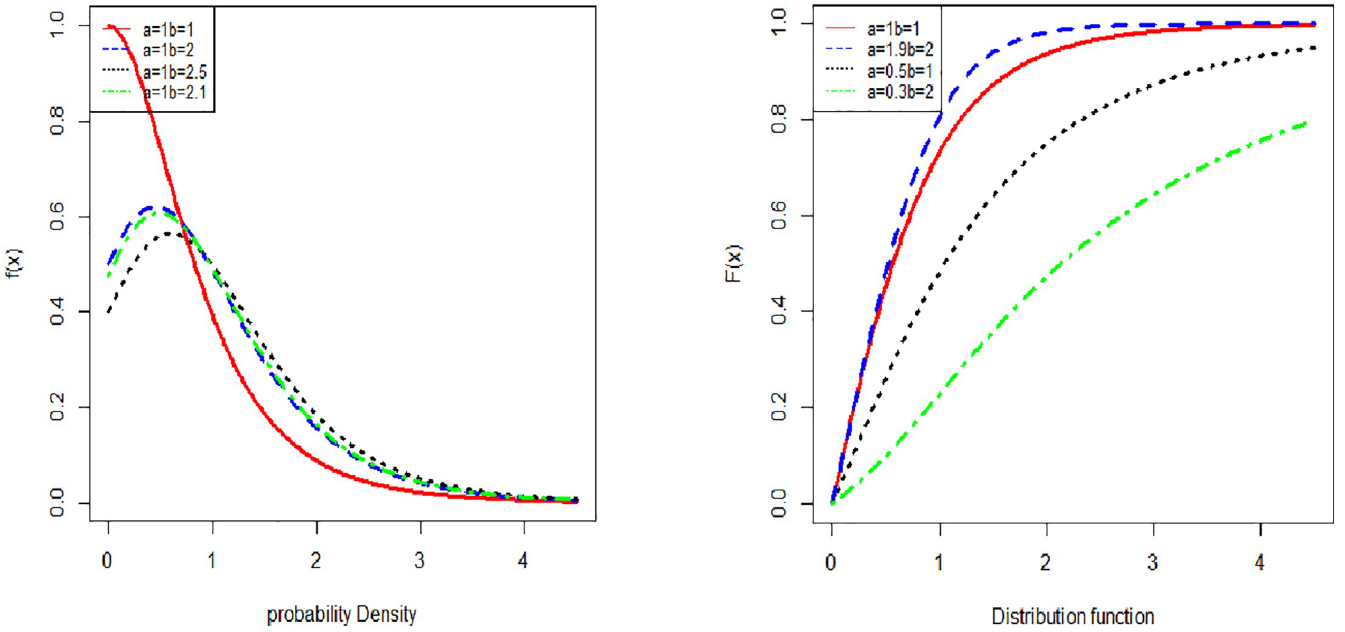
Fig 1. Shapes of the Pdf and Cdf of Lomax exponential